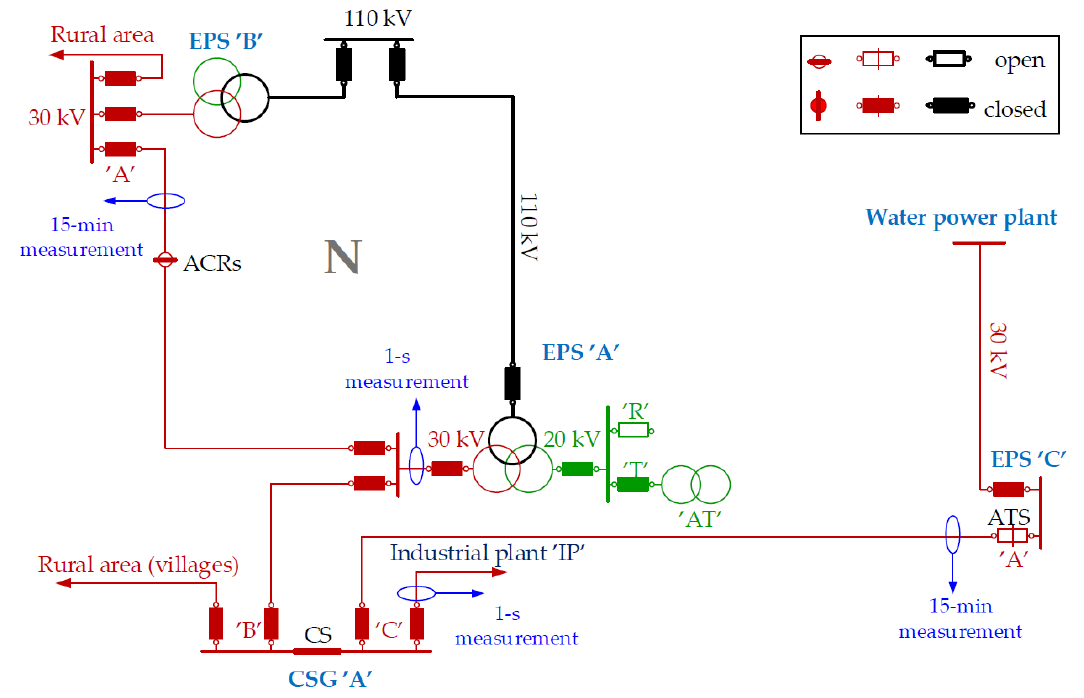
Figure 1. The system structure of the considered network in the normal operational condition N.